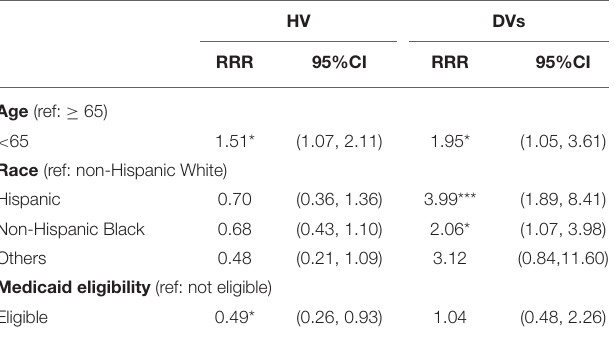
TABLE 3 | Multinomial logit regression examining differences in risk factors across three detected latent vulnerability groups (reference group: MV, N =